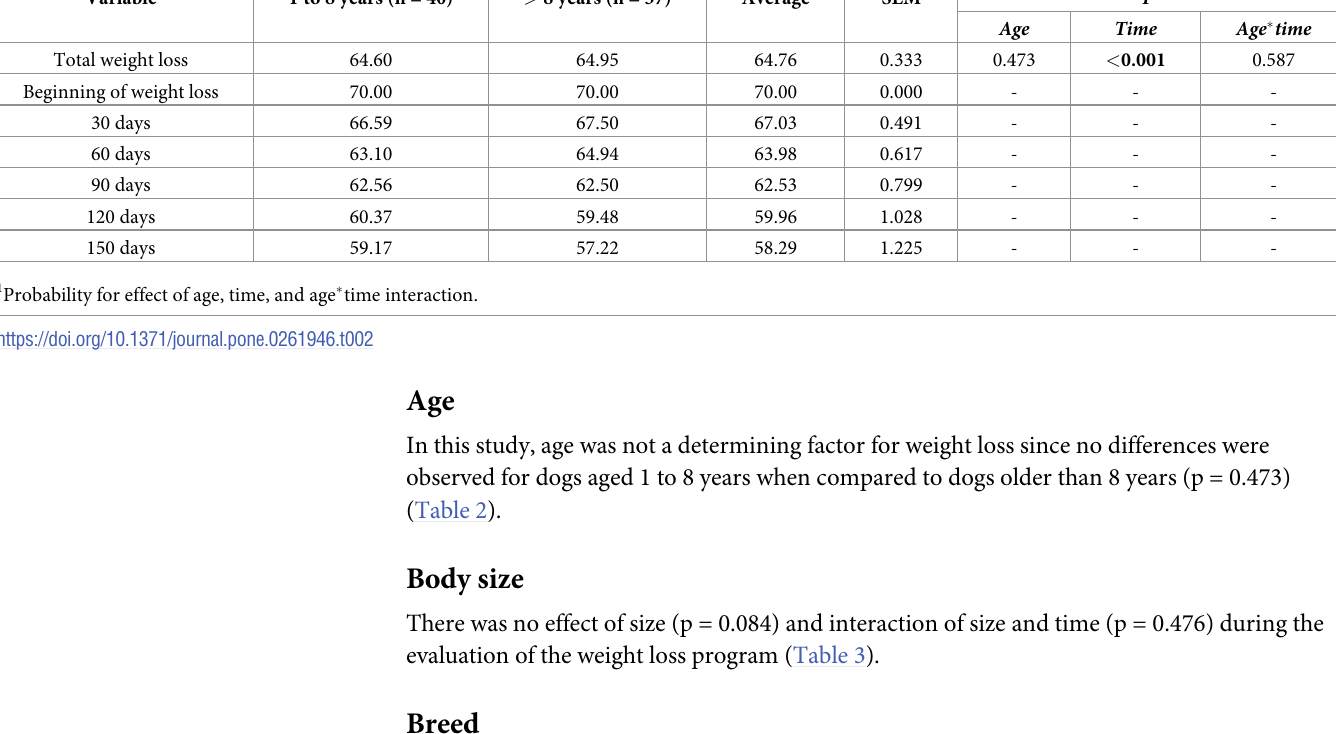
Table 2. Calorie intake per target weight 0.75 according with age. Variable